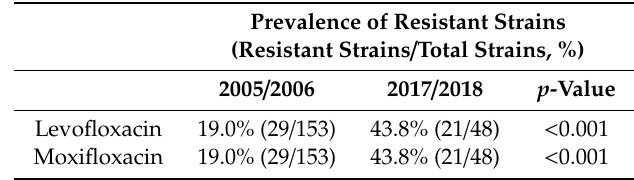
Table 2. Prevalence of fluoroquinolones resistance among H. pylori isolates in 2005 / 2006 and 2017 / 2018.